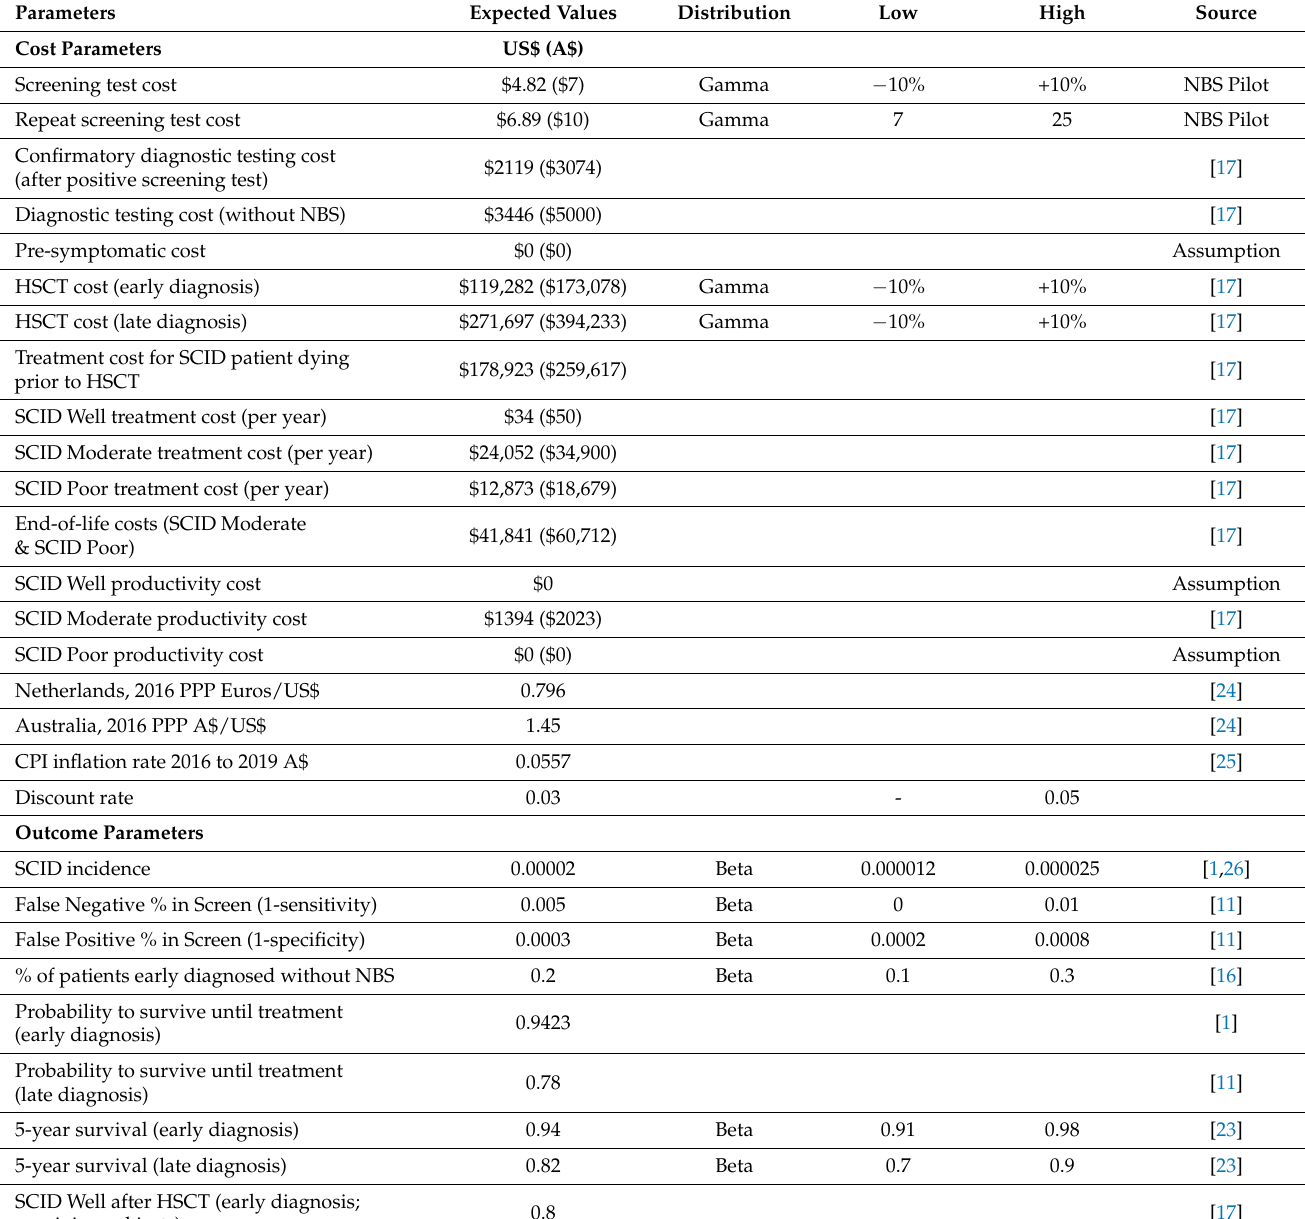
Table 2. Model parameter and expected values with ranges for Markov model ($ 2018